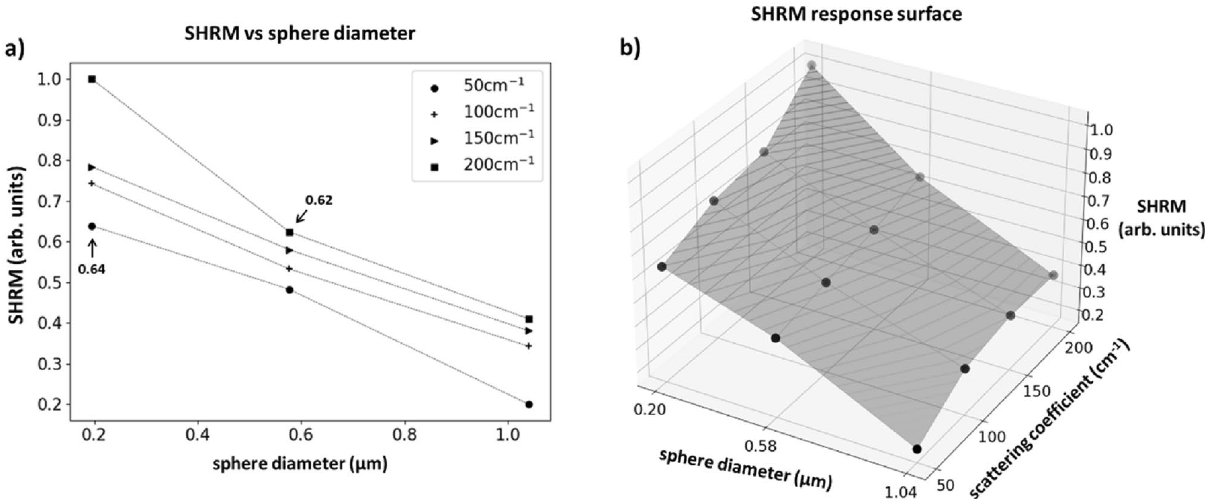
Figure 9. The composite ‘spatial helicity response’ metric (SHRM) is highly sensitive to sphere diameter with essentially linear dependence, and modestly sensitive to turbidity. The SHRM is plotted as ( a ) a 2D scatter plot and ( b ) a 3D response surface against scatterer diameter and scattering coefficient. The SHRM enables simultaneous quantification of scatterer size and turbidity, except at lower values of µ s where this unique association becomes ambiguous (arrows in ( a ); for details, see text). The data are normalized by the 0.20 μm, µ s = 200 cm −1 SHRM value. Symbols represent experimental results; the lines are a guide for the